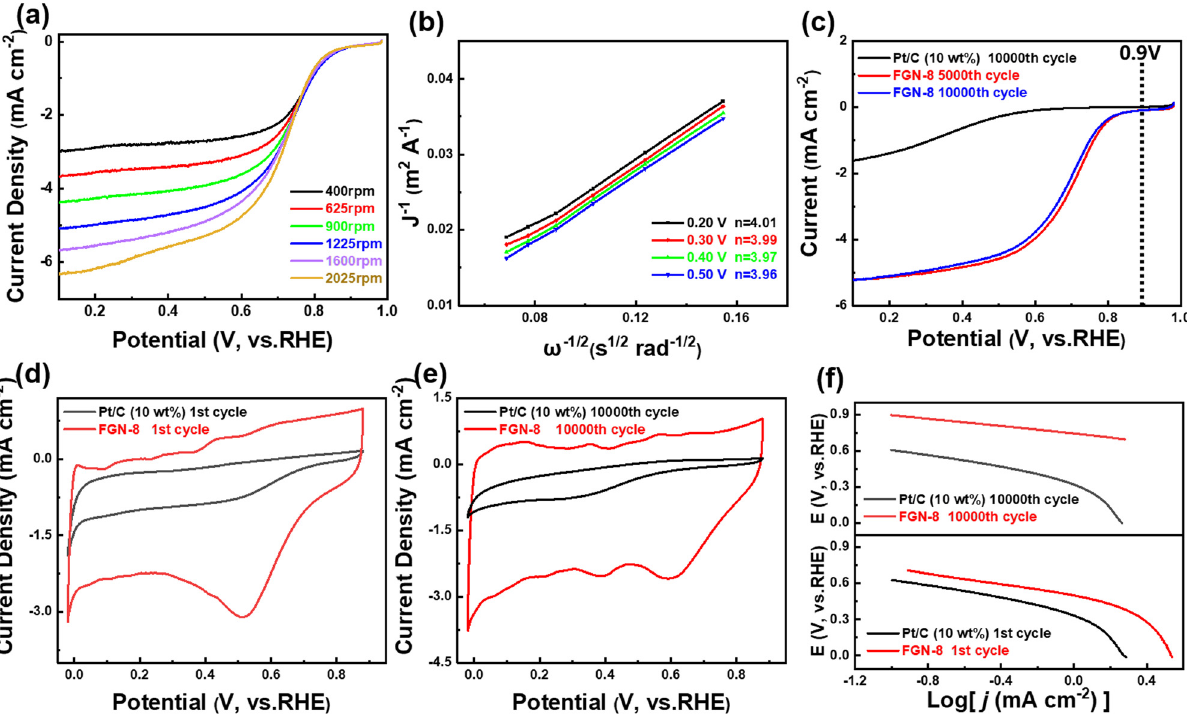
Figure 6: ( a ) LSV curves at di ff erent rotation rates of FGN - 8. ( b ) K – L plots of FGN - 8. ( c ) LSV curves of Pt/C and FGN - 8 after 5,000th and 10,000th cycles. All the LSV curves were tested in O 2 - saturated 0.5 M H 2 SO 4 solution with a scan rate of 5 mV s − 1 and ( d and e ) CV curves of commercial 10% Pt/C and FGN - 8 before and after 10,000 cycles. ( f ) Tafel plots of Pt/C and FGN -